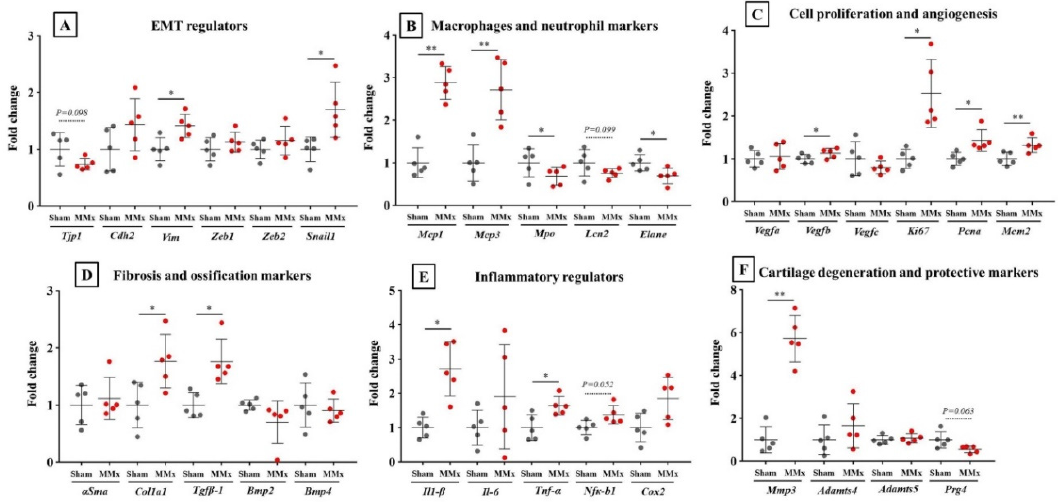
Figure 7. Synovitis-associated gene expression levels in the synovium. ( A – F ) Gene expression levels of synovitis-associated genes. * p < 0.05, ** p < 0.01 on paired t -test. EMT, epithelial–mesenchymal